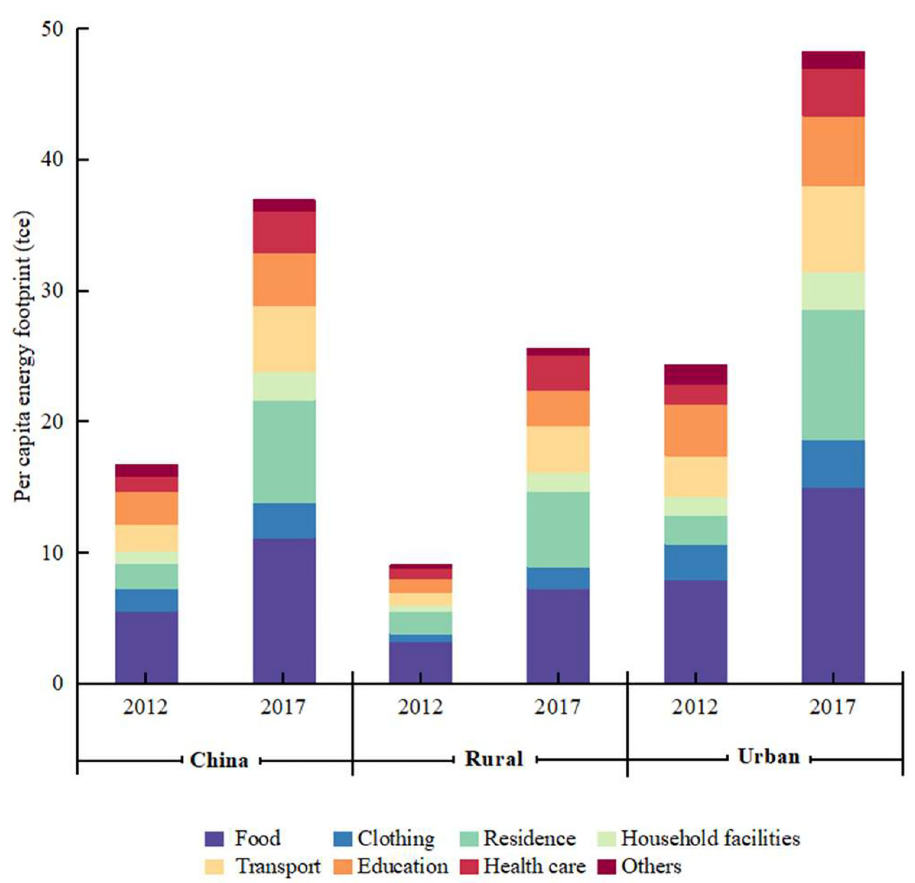
Fig 3. The PCHEF for eight consumption types in urban and rural China in 2012 and